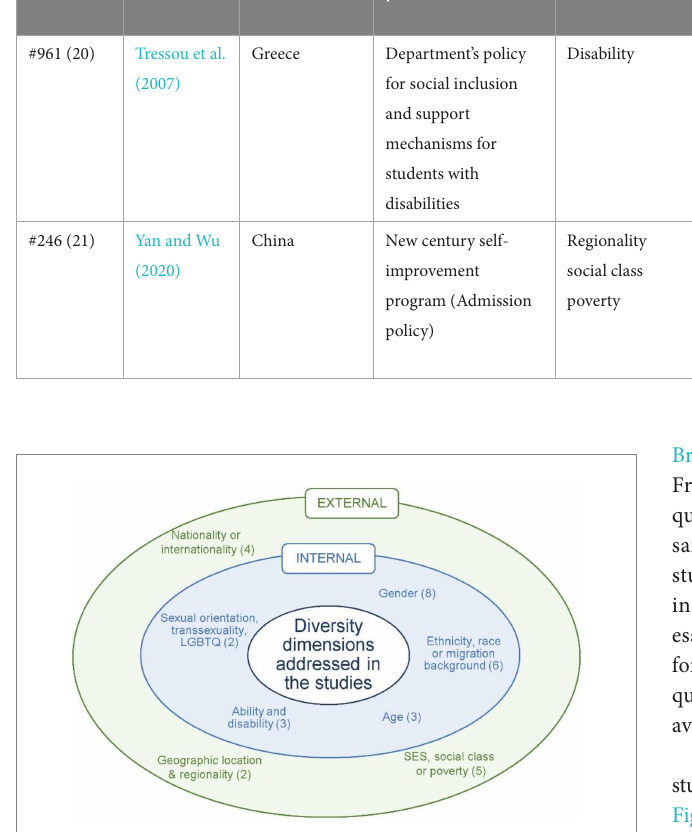
FIGURE 2 Diversity dimensions in the extracted studies (more than one dimension per study